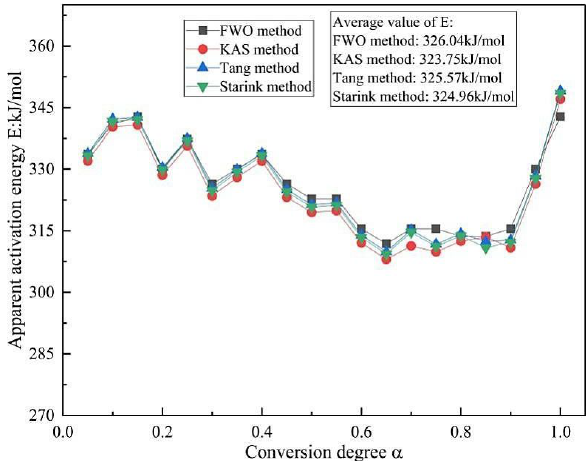
Figure 4: Variation of apparent activation energy E with α for car- bothermal reduction of phosphate rock with particle size 48-75 µ m by different method